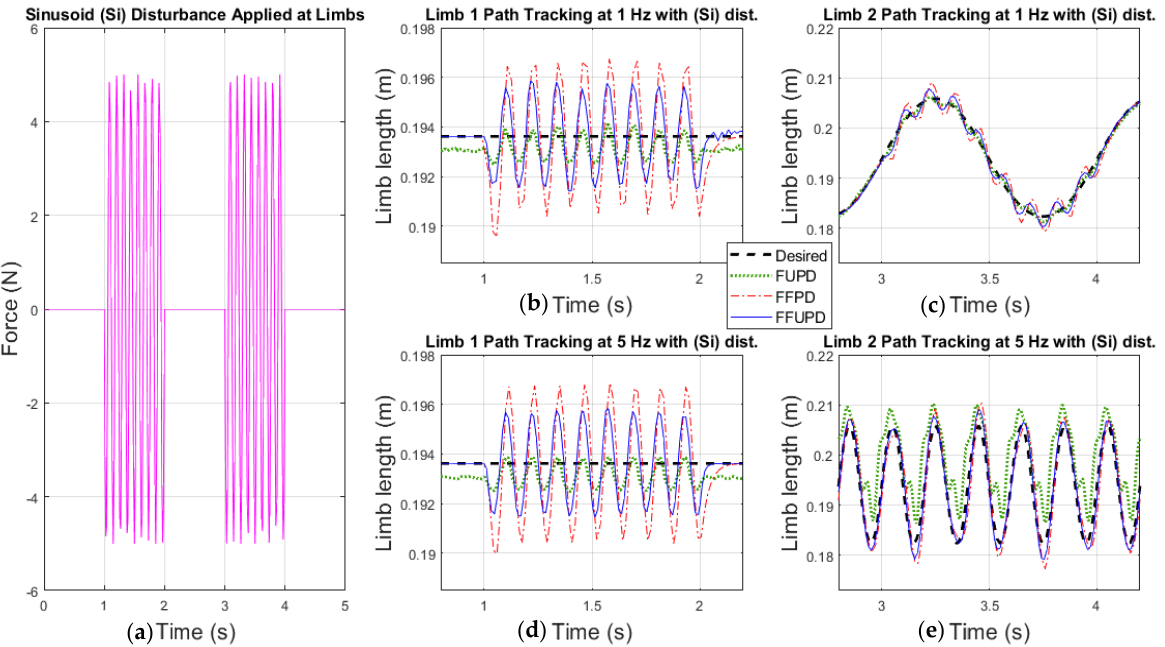
Figure 15. ( a ) Sinusoid disturbance applied to limbs’ line of action; ( b , d ): limb 1 controlled by FUPD, FFPD and FFUPD during perturbation at 1 and 5 Hz, respectively; ( c , e ): limb 2 behavior at 1 and 5 Hz (respectively) during perturbation.